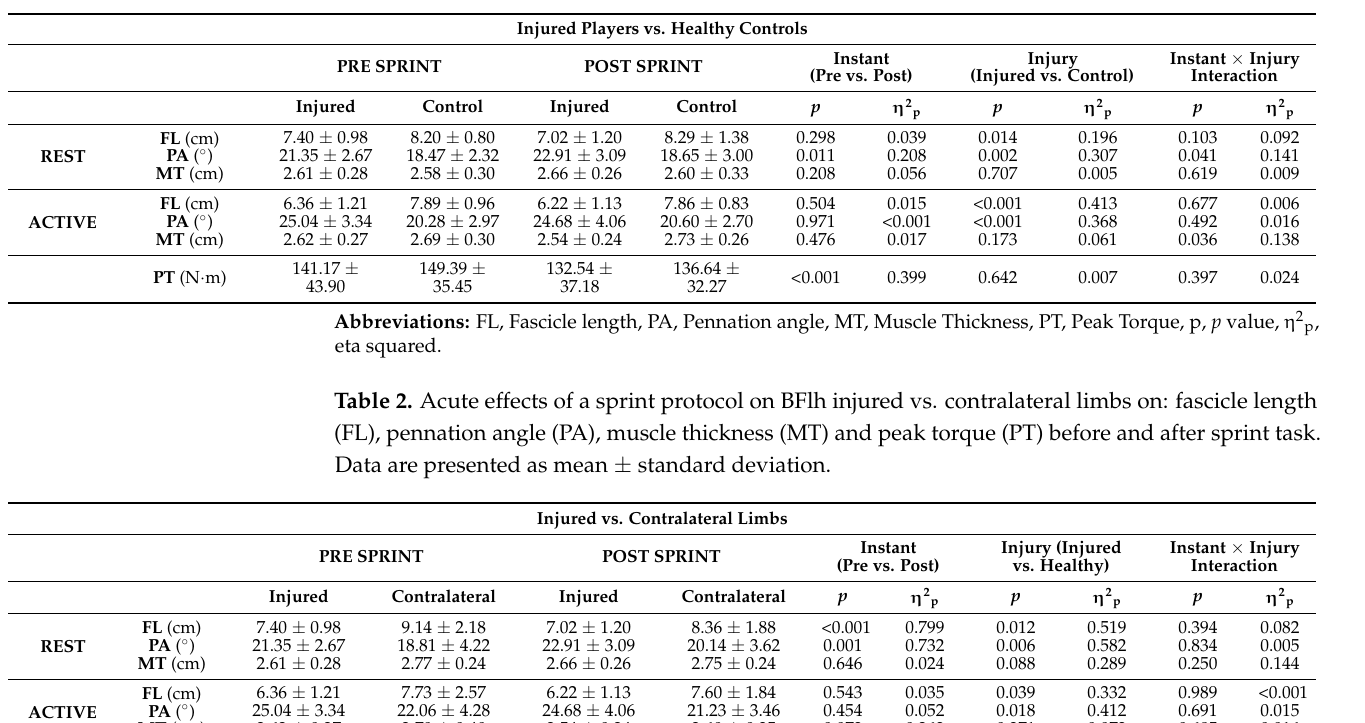
Table 1. Acute effects of a sprint protocol on BFlh injured players vs. healthy controls on: fascicle length (FL), pennation angle (PA), muscle thickness (MT) and peak torque (PT) before and after the sprint task. Data are presented as mean ± standard deviation.